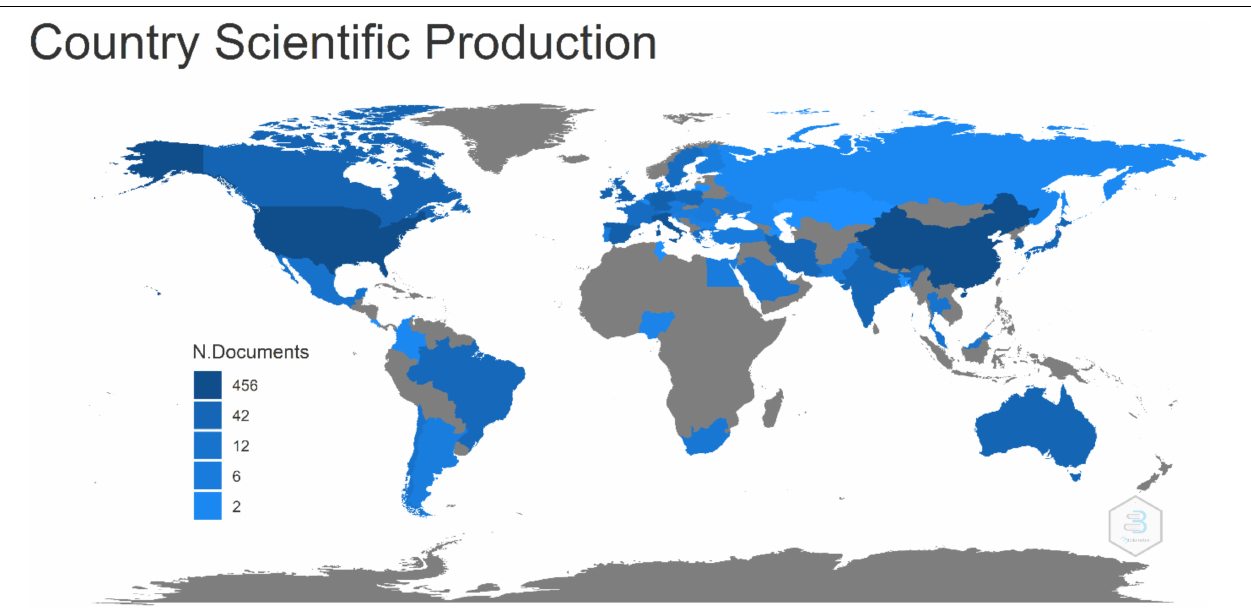
FIGURE 4 | Number of publications per country based on